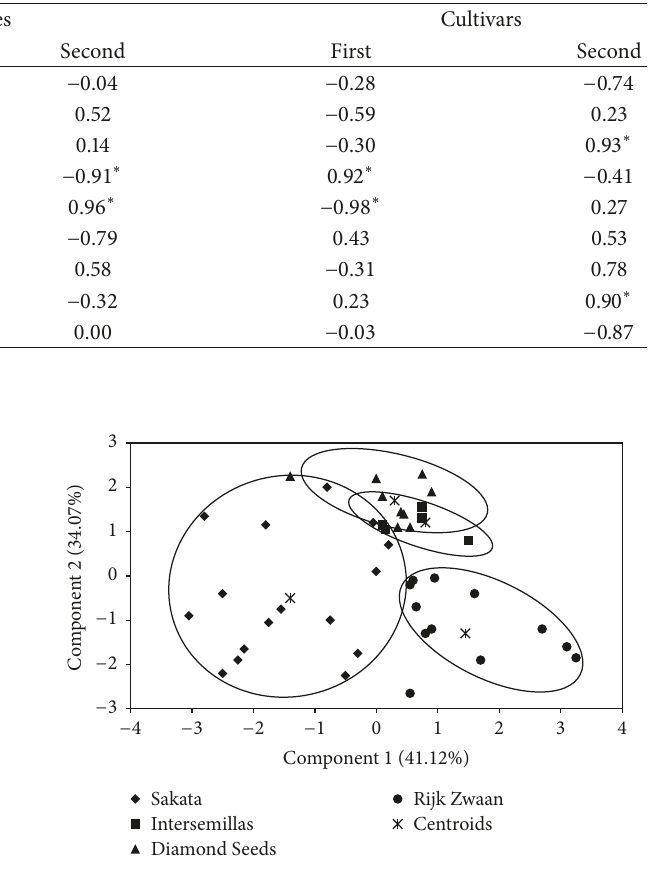
Figure1:PCAplotshowingthetwomajorcomponentsofvariability among the considered cultivars.